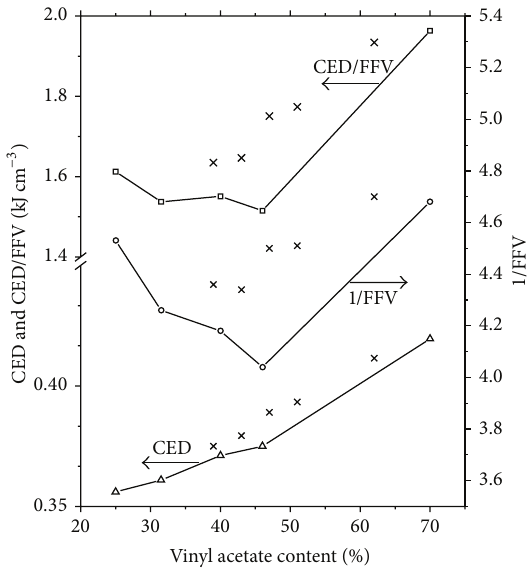
Figure 1: Dependence of CED and CED/FFV on VA content for pure EVA copolymers (empty symbols) and for copolymer blends (stars). Dependence of 1/FFV was plotted based on the data from the previous work [17] with permission from A. Wolinska-Grabczyk,